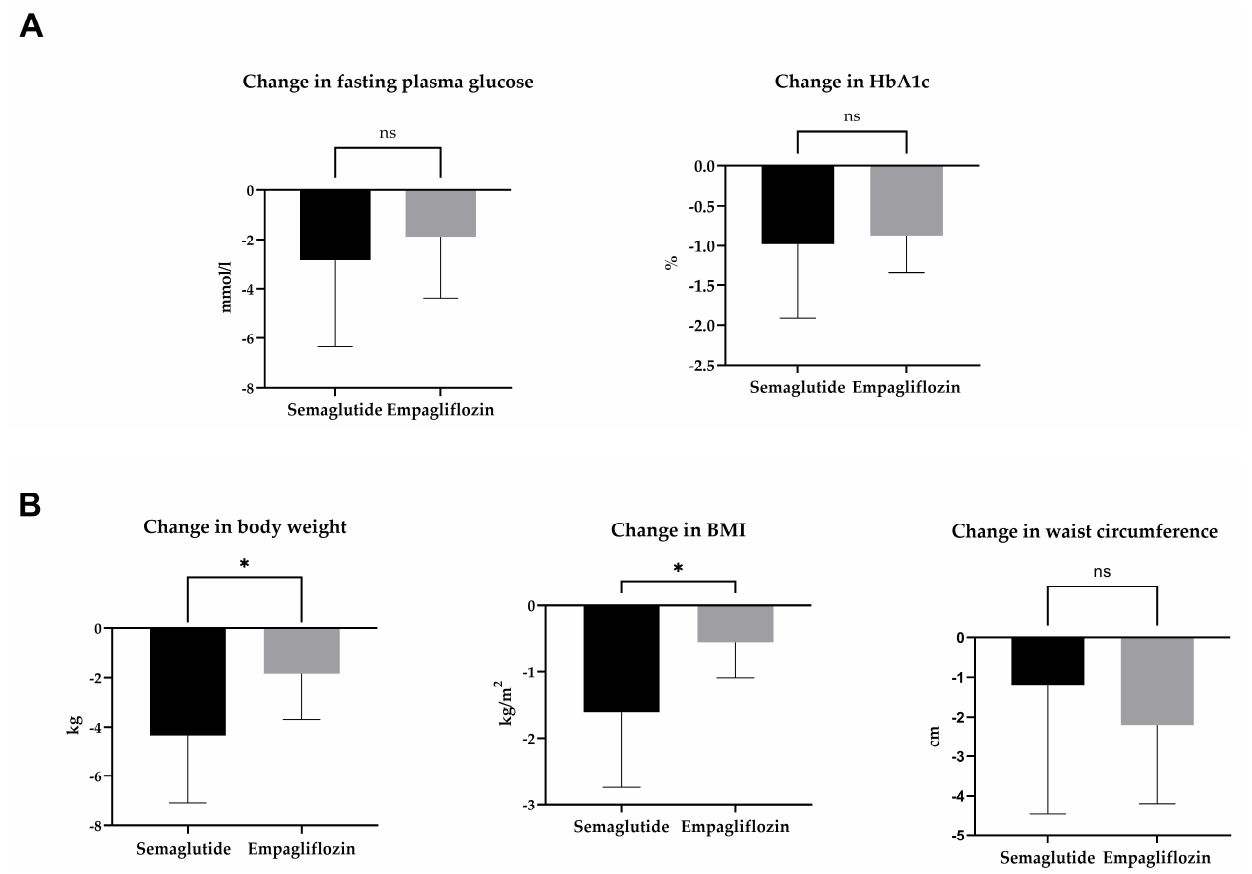
Figure 1. Change in glycaemic control ( A ) and anthropometric parameters ( B ) after 3 ‐ month with semaglutide or empagliflozin. Statistics: Unpaired t -test; mean ± SD; * p < 0.05; ns: p ≥ treatment with semaglutide or empagliflozin. Statistics: Unpaired t ‐ test; mean ± SD; * p < 0.05; ns: p ≥ 0.05.